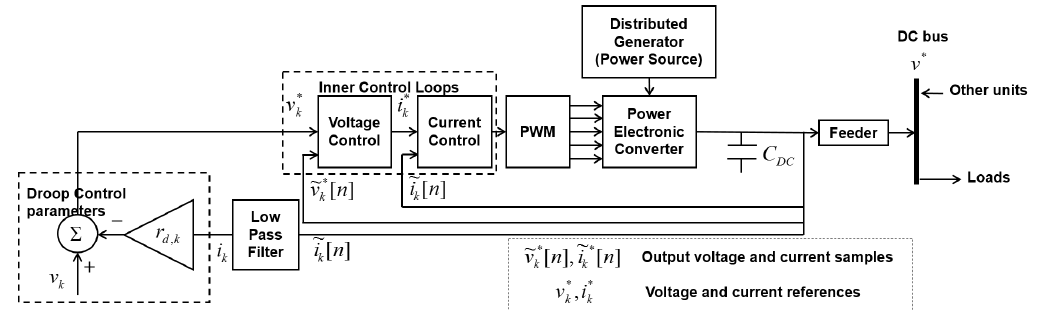
Figure 2. Primary control loops of power electronically-controlled